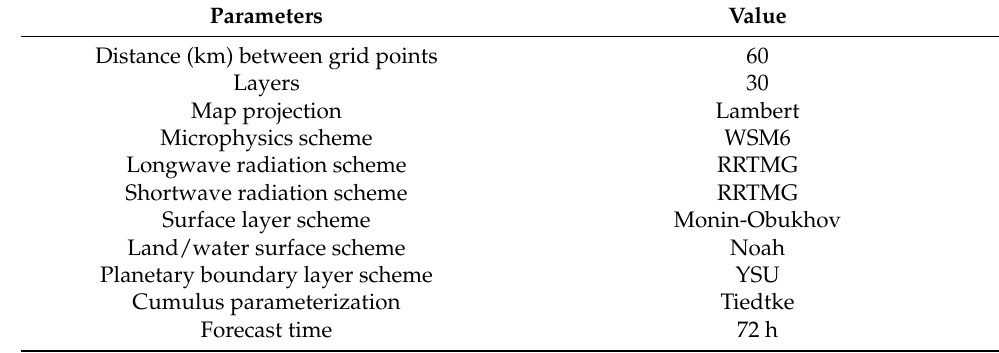
Table 1. Parameters for the Weather Research and Forecasting (WRF) model. Parameters Value Distance (km) between grid points 60 Layers 30 Map projection Lambert Microphysics scheme WSM6 Longwave radiation scheme RRTMG Shortwave radiation scheme RRTMG Surface layer scheme Monin-Obukhov Land/water surface scheme Noah Planetary boundary layer scheme YSU Cumulus parameterization Tiedtke Forecast time 72